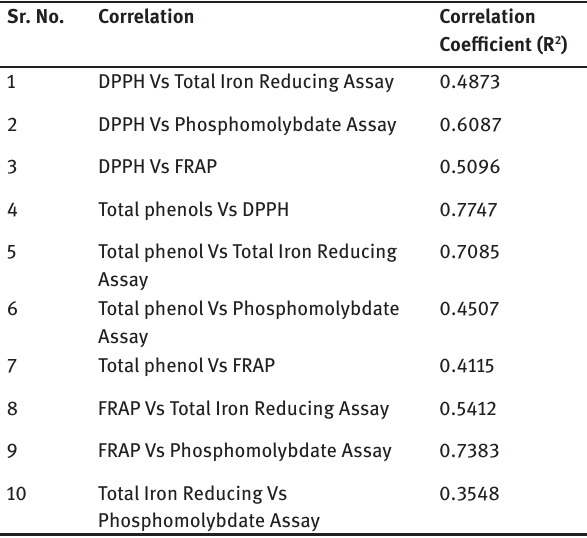
Table 3: Correlation Coefficient. Sr.